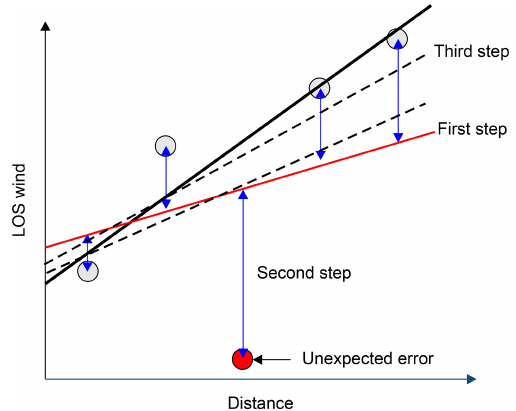
Figure 6. Conceptual explanation of Tukey’s biweight methodology applied to LOS wind at various distances. The first step is the sim- ple least-squares fit. The second step is observations are compared with the estimate. The data are weighted, and extreme outliers are excluded, using Eq. (6). The third step is the least-squares fit of the weighted